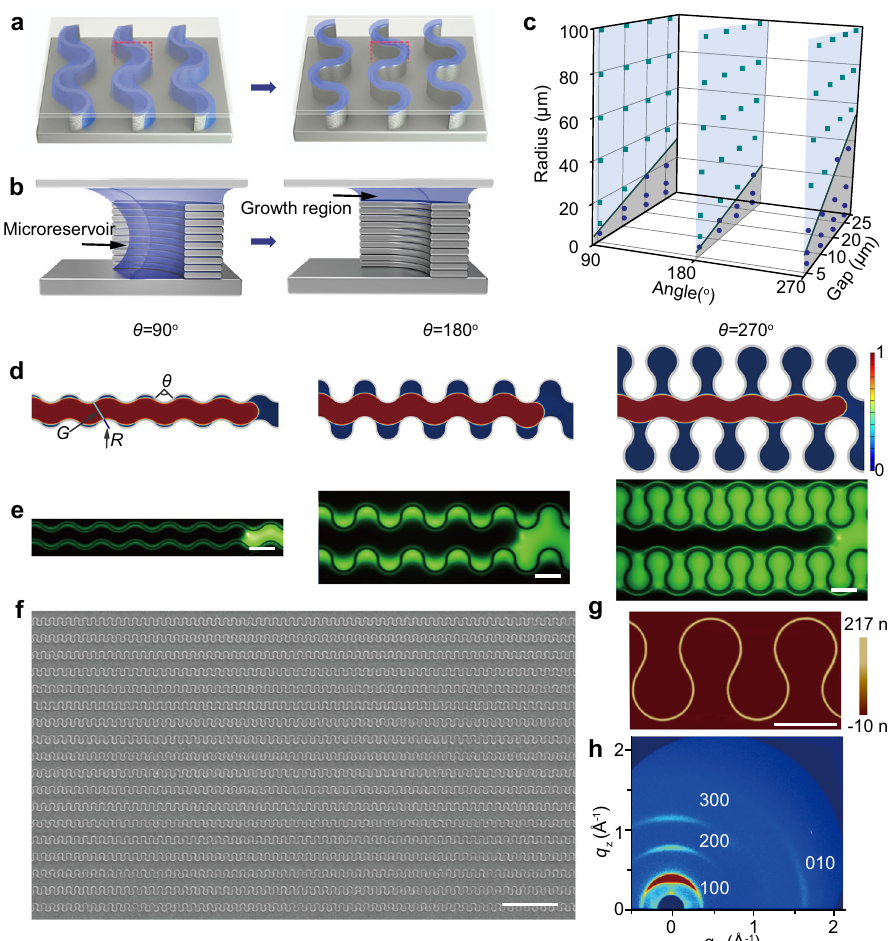
Fig. 1 Capillary-gradient manipulation for the fabrication of ordered curvilinear polymer microstructures. a Schematic illustrations of dewetting and assembling processes of curvilinear polymer microstructures using a capillary-gradient assembly method. b Corresponding cross-sectional view schemes of ( a ). c Liquid trapping in microreservoirs as functions of arc radius R , arc angle θ , and minimum gap distance G of micropillars. The symbols of blue dots and green squares represent successful and unsuccessful trapping of liquid, respectively. The solid lines highlight the calculated threshold gap distances (see details in Supplementary Note 3). d , e Simulations and fl uorescence microscope images of the liquid trapping in inner arc edge of the micropillar with central arc angle θ of 90 o , 180 o , and 270 o . f Representative SEM image of large-area curvilinear polymer microstructure arrays with θ = 270 o . g AFM topography and height diagram of a curvilinear P3HT microstructure with θ = 270 o . h GIWAXS pattern of curvilinear P3HT microstructure arrays with the central arc angle θ = 270 o , indicating the edge-on stacking of polymer chains. Scale bars: e 10 μ m, f 100 μ m, g 10 μ